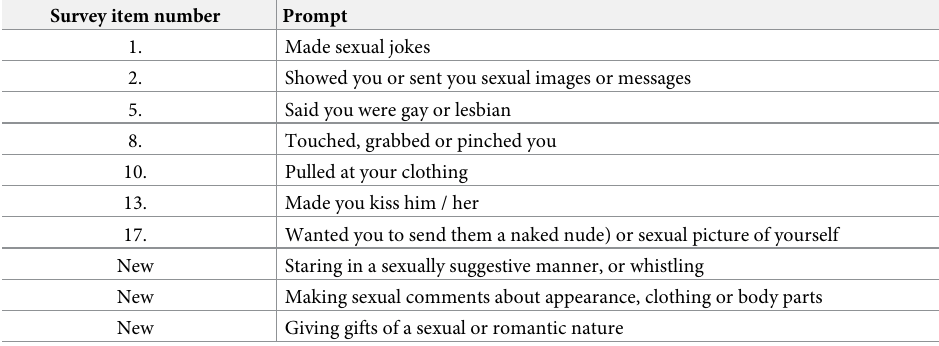
Table 2. Discussion prompts (with number of equivalent survey